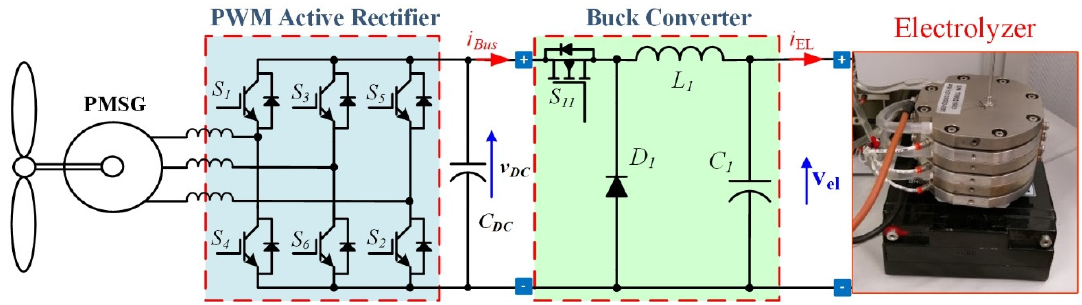
Figure 6. Hydrogen production systems supplied by wind energy with front-end based on active rectifier.